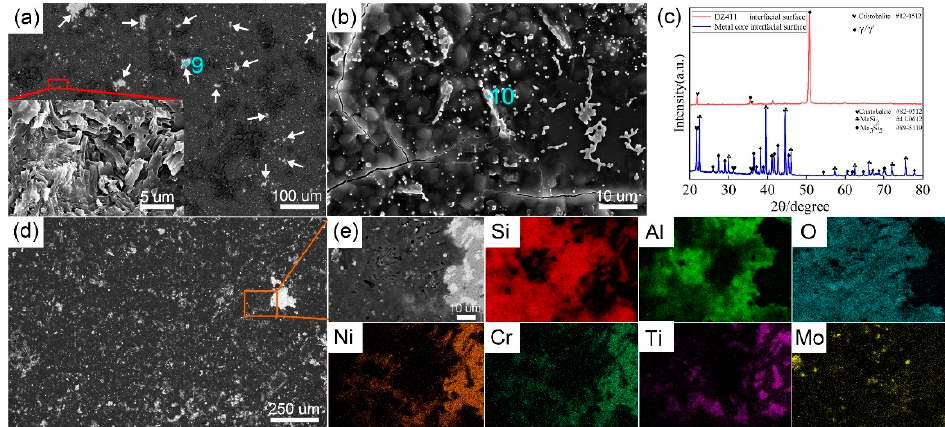
Figure 5. ( a ) The surface BSE image of the metal core in the DSM11 position. ( b ) The surface SEM image of the metal core in the shell position. ( c ) XRD patterns of the metal core and DSM11 interfacial surface; BSE image of the DSM11 interfacial surface. ( d ) Low magnification and ( e ) high magnification, corresponding Si, Al, O, Ni, Cr, Ti, and Mo mappings of Figure 5e.